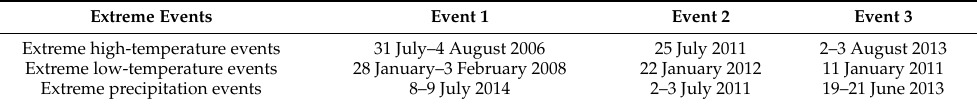
Table 2. The nine selected extreme events in Northwest China, 2004–2014. Extreme Events Event 1 Extreme high-temperature